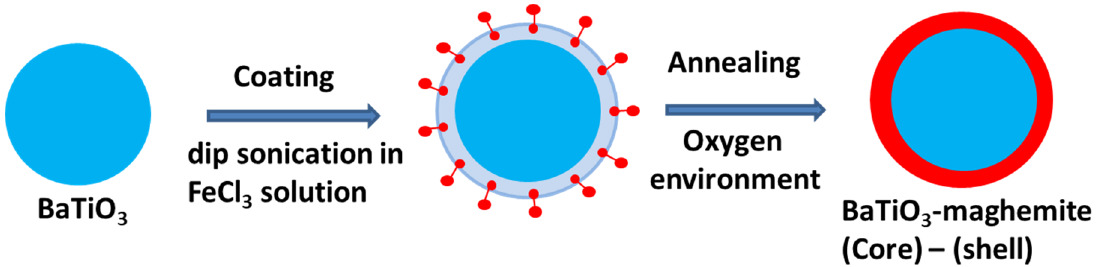
Figure 1. Schematic illustration of the synthesis of perovskite oxide/ferrite core–shell nanostructures.